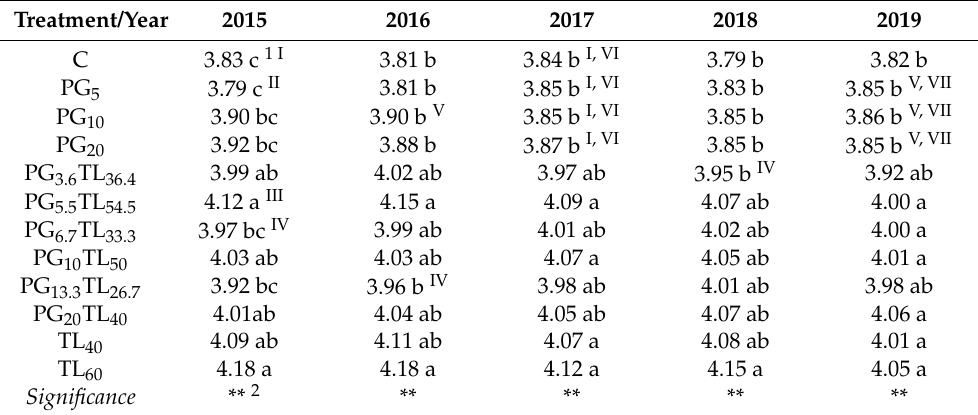
Table 9. Effect of treatments and years on the content of organic carbon (C org , %) at 0–20 cm soil layer.